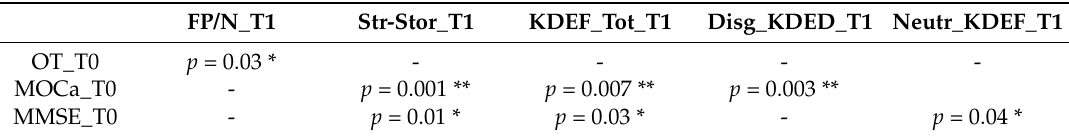
Table 2. Correlations at the follow-up analysis in HD